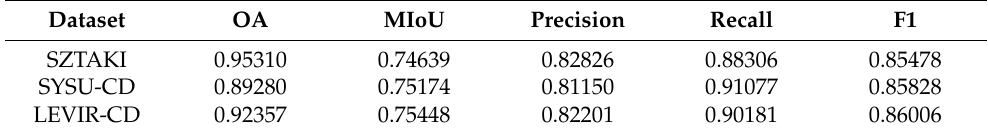
Table 7. The experiment results of multi-attention SFA on three standard datasets.